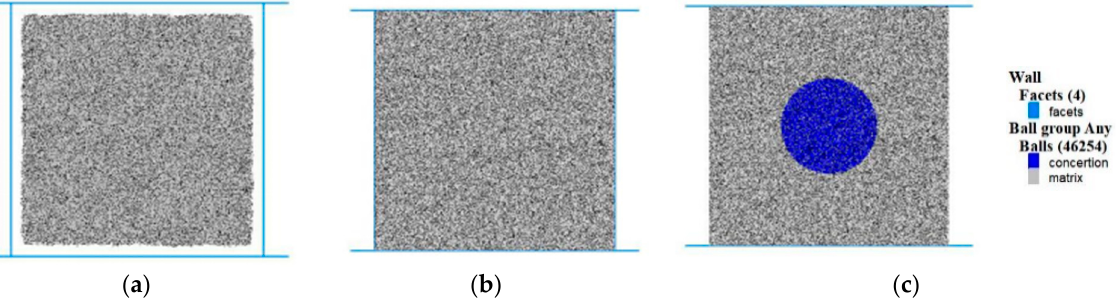
Figure 4. Flow chart for the establishment of the specimens: ( a ) generation of rock mass (matrix); ( b ) balancing the model; ( c ) determining and generating the concretion.